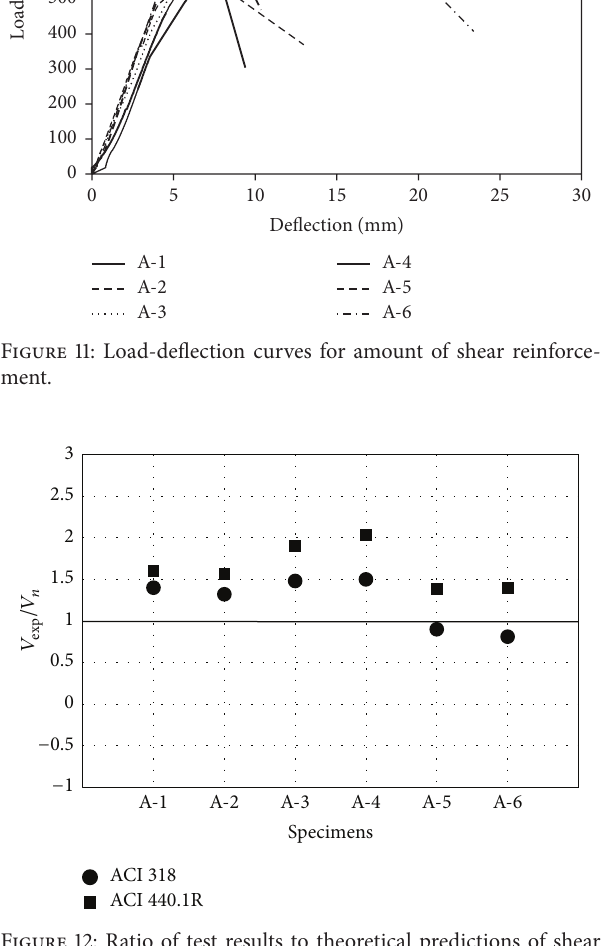
Figure 12: Ratio of test results to theoretical predictions of shear strength ( 𝑉 exp /𝑉 𝑛